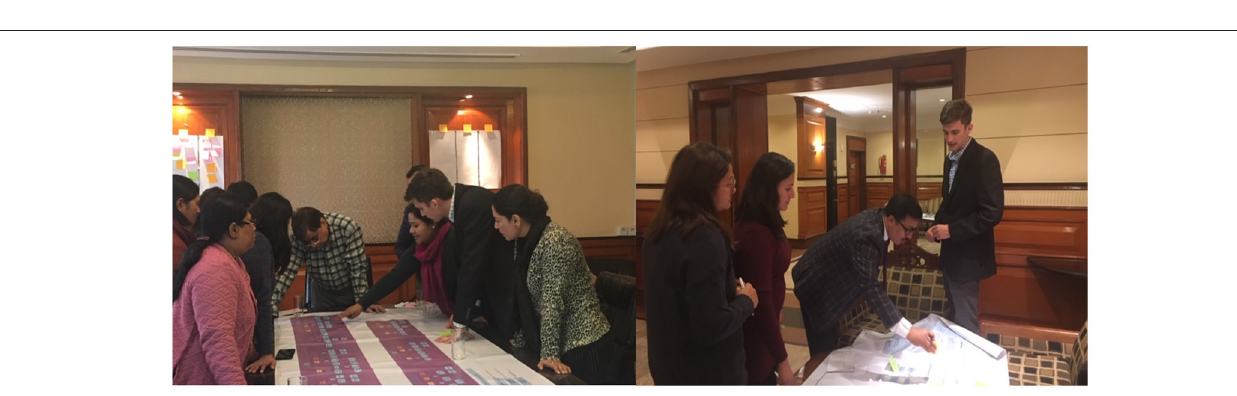
FIGURE 2 | Discussing pre-defined process flowcharts to inform app design with the Nepal team during a fieldsite